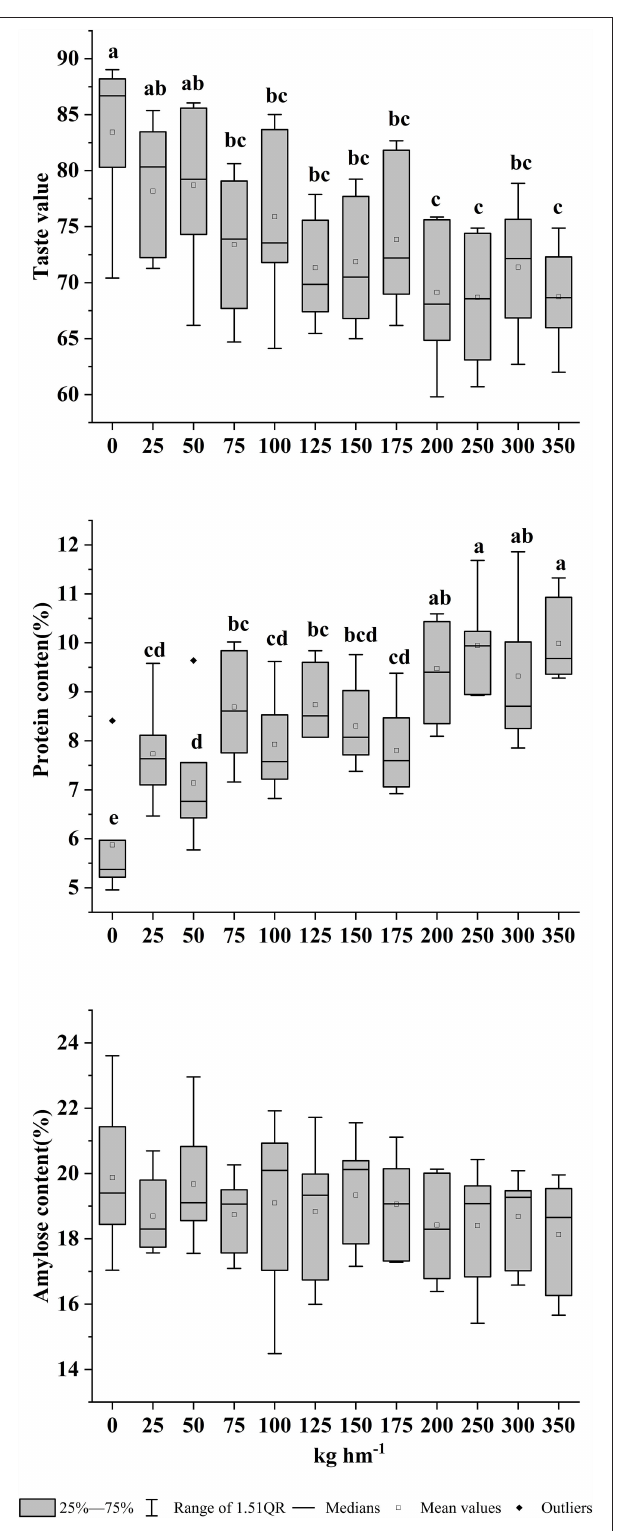
FIGURE 2 | Cluster analysis of taste value of various rice varieties under different nitrogen fertilizer conditions. HTV refers to high taste value type, MTV1 and MTV2 refer to medium taste value type, and LTV refers to low taste value